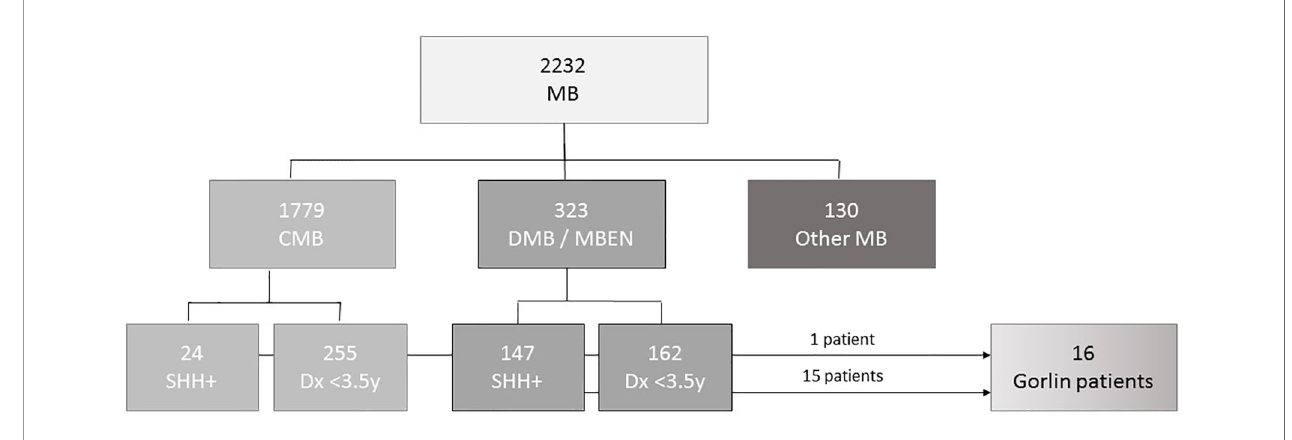
FIGURE 1 | CONSORT diagram of the cohorts ’